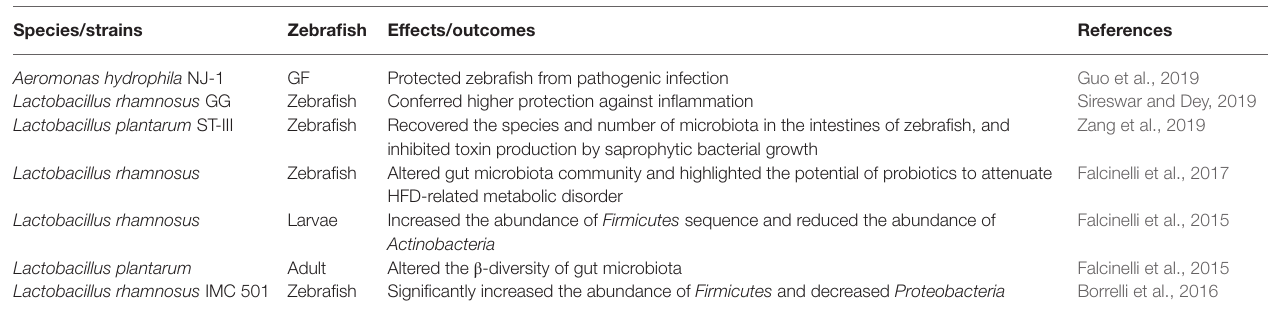
TABLE 1 | Various probiotic with the change intestinal microbial composition.